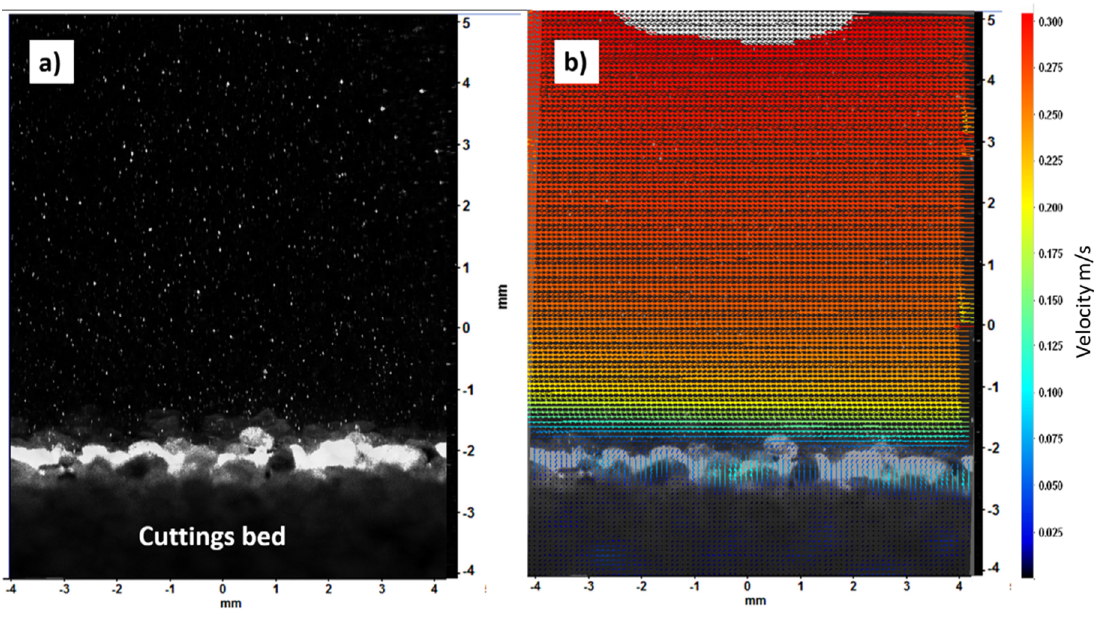
Figure 5. ( a ) Typical PIV image acquired during the tests, and ( b ) the resultant velocity field.